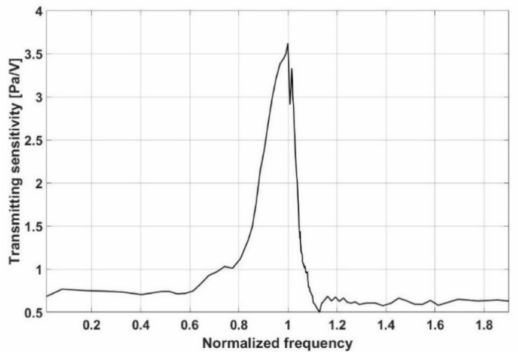
Figure 4. Transmitting sensitivity of the proposed single absorber.